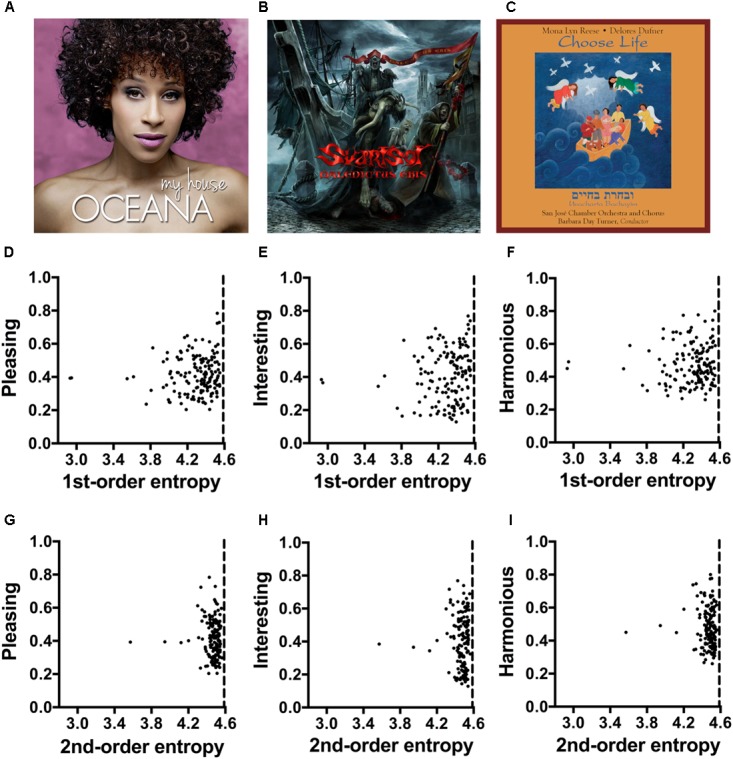
(A–C) Typical examples of album covers (Experiment 5) for pop music (A), metal music (B) and classic music (C). The values for the image properties of each image are listed in Supplementary Table S4. Due to copyright issues, the covers used in the rating experiment are not reproduced here. The images in (A–C) are in the public domain and were downloaded from Wikimedia Commons. (D–I) Dot plots of 1st-order entropy (D–F) and 2nd-order entropy (G–I)
versus the ratings for pleasing
(D,G), interesting (E,H) and harmonious (F,I), averaged across participants. Each dot represents the results for one image. Single regression analyses did not yield slopes that were significantly different from zero (D, R2 = 0.009; F[1,148] = 1.31, p = 0.254; E, R2 = 0.013; F[1,148] = 1.92, p = 0.168; F, R2 = 0.002; F[1,148] = 0.358, p = 0.551; G, R2 = 0.003; F[1,148] = 0.41, p = 0.524; H, R2 < 0.01; F[1,148] = 0.001, p = 0.975; I, R2 = 0.007; F[1,148] = 1.06, p = 0.305).